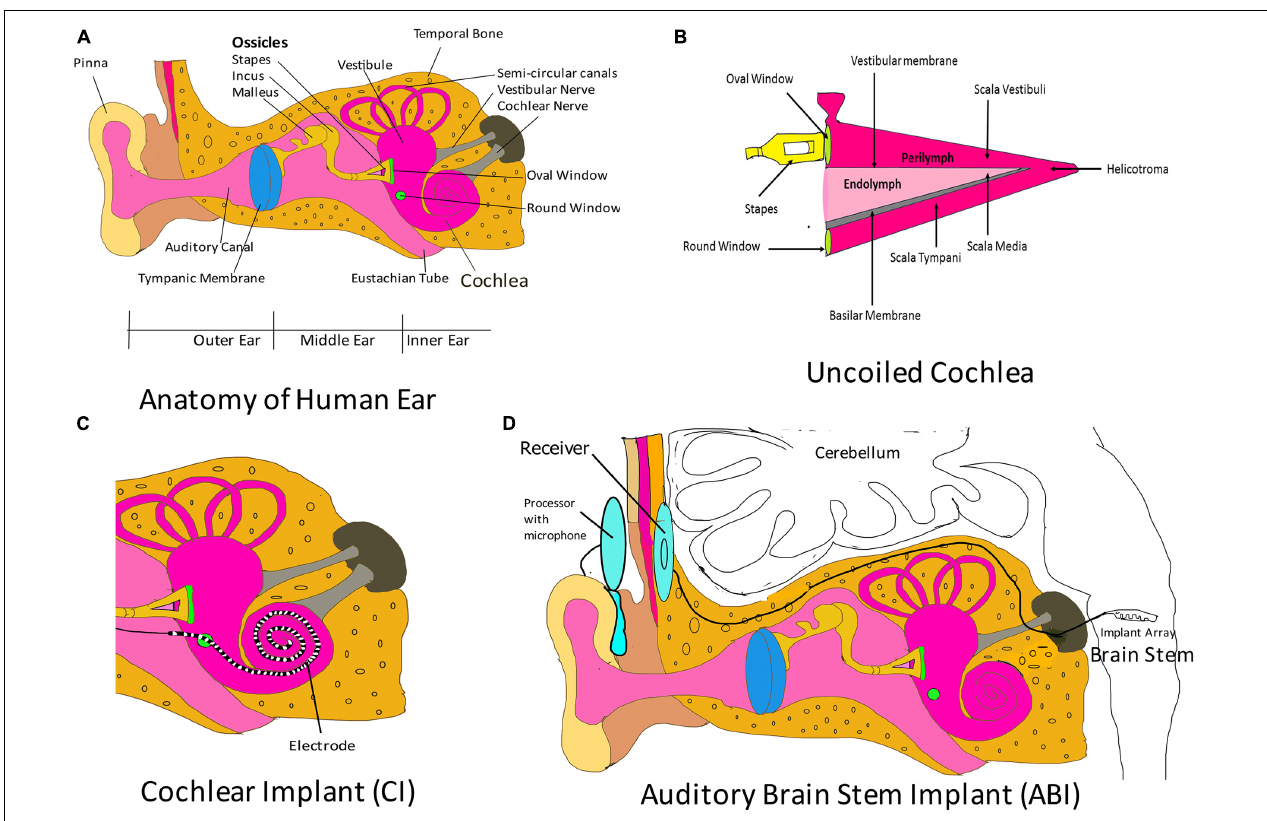
FIGURE 2 | Auditory implants. (A) Parts of the human ear. The outer ear comprises the pinna, the concha, and the ear canal. The middle ear components are the tympanic membrane and the three ossicular bones: malleus, incus, and stapes. The stapes connects the middle ear to the inner ear fluid-filled labyrinth through the oval window. The inner ear is divided into three regions: cochlea (which transduces sound through the auditory nerve to the auditory brain centers), vestibule, and semi-circular canals (chiefly associated with maintenance of balance). Please note that the components shown here are not drawn to scale. The purpose of this cartoon is solely to enhance the comprehension by the reader of the ear parts. (B) Uncoiled cochlea. The cochlea is divided into three compartments (scala vestibuli, scala media, and scala tympani) by two membranous structures: the vestibular membrane and the basilar membrane. The scala media contains endolymph and houses the Organ of Corti, which rests on the basilar membrane. The Organ of Corti contains sensory cells, which synapse with auditory nerve and are responsible for sound transmission to the auditory regions of the brain. Please note that here the figure parts are also not drawn to scale. (C) Cochlear implant (CI). The CI consists of an electrode that is introduced to the cochlea through the round window. This electrode is designed to maintain the tonotopism of an intact cochlea. It receives electrical signal from a subcutaneous implant (receiver) and serves to directly stimulate the auditory nerve. Please note that here that the figure parts are also not drawn to scale. (D) Auditory brain stem implant (ABI). This system consists of an electrode array implanted in the brain stem that collects signals from a receiver, which receives transmitted signals from an external processor. The external processor converts sound waves obtained from the integrated microphone into electrical energy and transmits it to the receiver. Figure parts are not drawn to